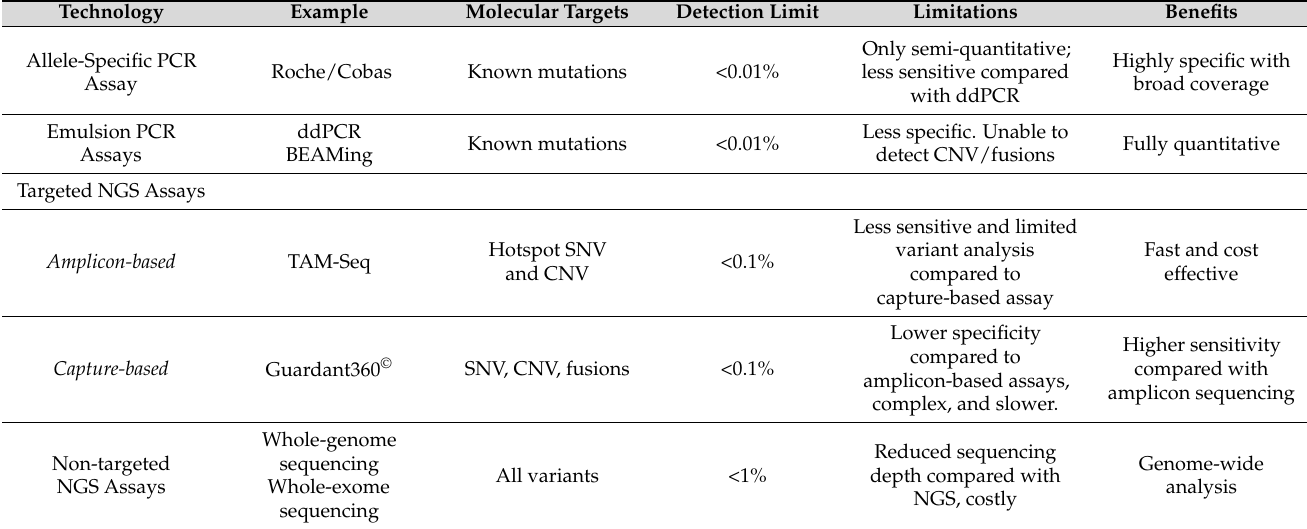
Table 2. ctDNA-sequencing